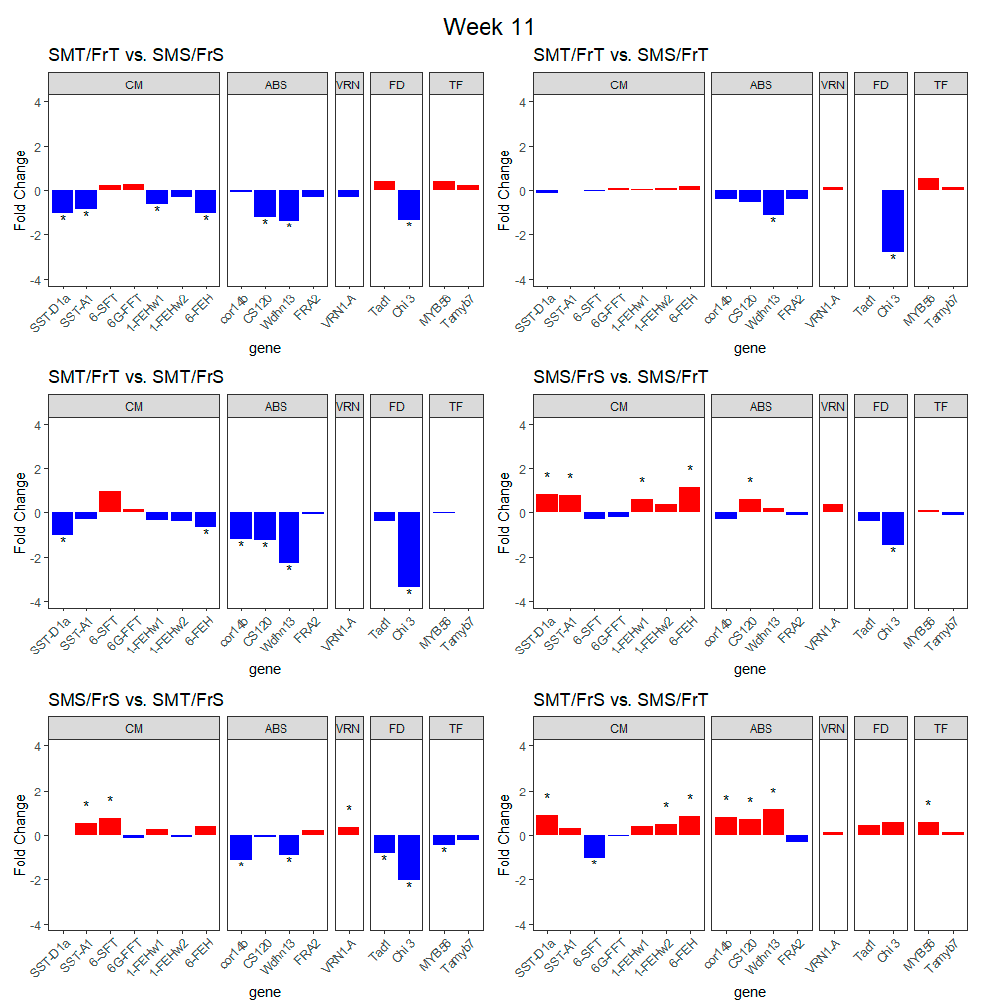
Figure 5. Fold change transcript expression between RILs of different classes of freezing and snow mold tolerance at week 11. Genes were grouped and labeled by the hypothetical function categories; carbohydrate modification, drought/cold stress, vernalization, fungal defense, and transcription factor represented by the abbreviations CM, ABS, VRN, FD, and TF, respectively. “*” denotes genes with significant differences (q < 0.05) in transcript expression between RILs at week 11 of the study.